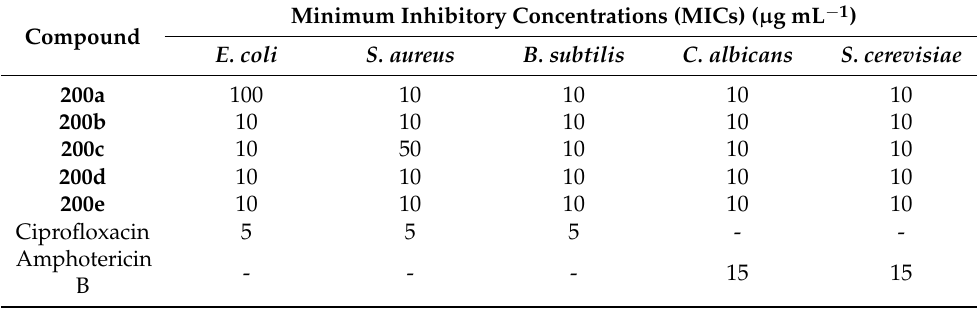
Table 13. Minimum inhibitory concentrations (MICs) of α -aminophosphonates 200a − 200e. Compound